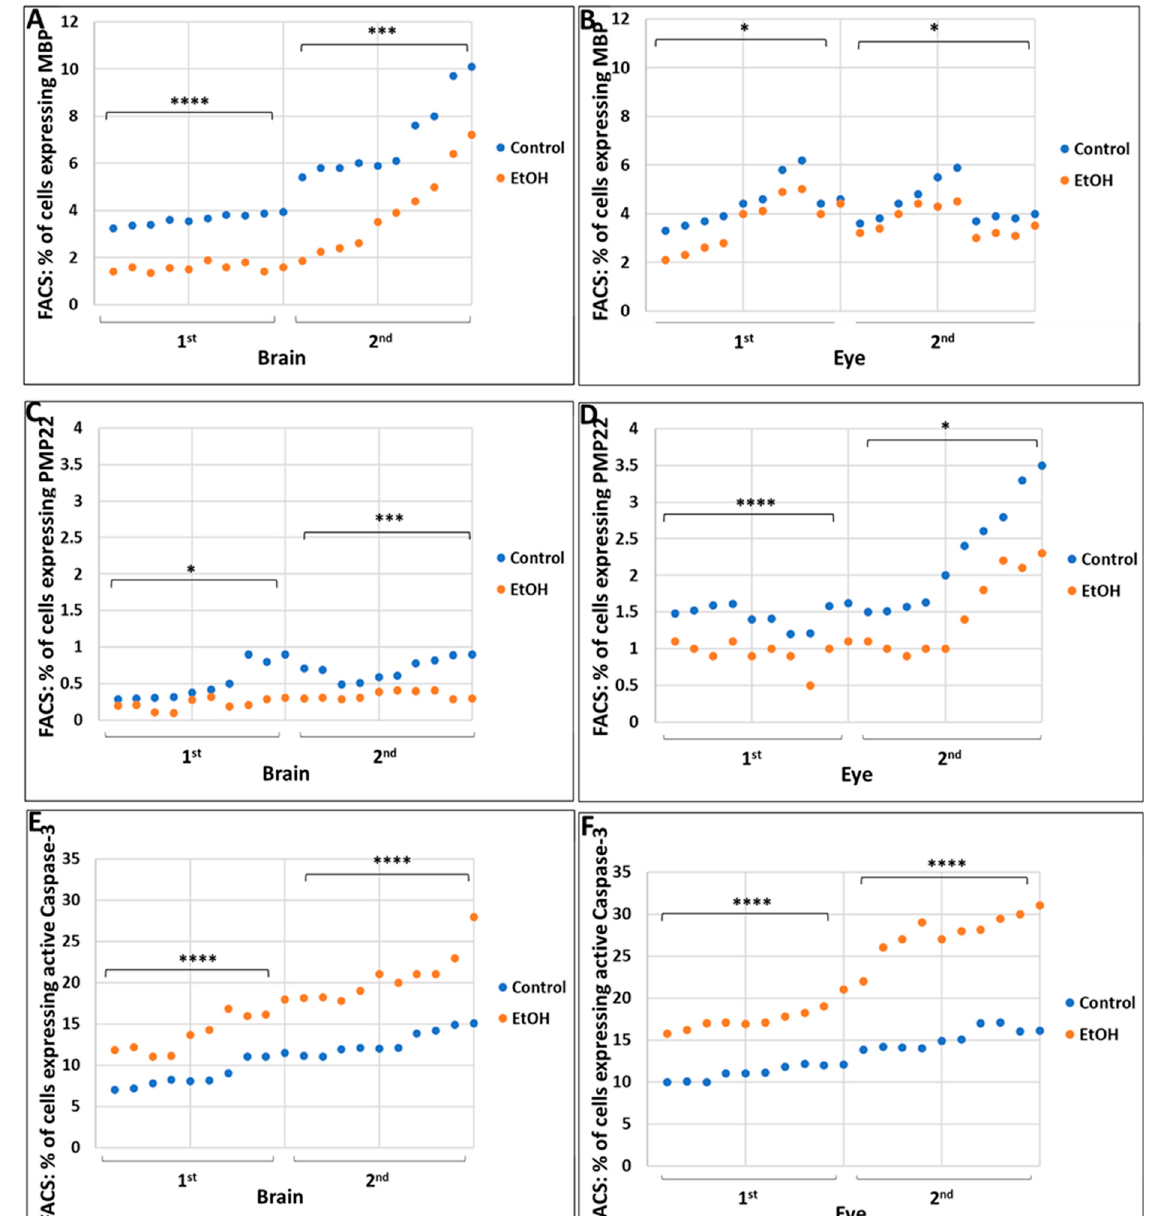
Figure 1. Prenatal alcohol exposure inhibits expression of markers for mature myelin, MBP and PMP22, and activates caspase-3 in human fetal brain and eye. The percentage of cells expressing molecular markers were determined by FACS in brains and eyes of fetuses exposed to EtOH, and compared with non-exposed controls. ( A ) EtOH-dependent reduction in the proportion of cells expressing the late stage OL marker, MBP, in brain and eye ( B ). ( C ) EtOH-dependent reduction of the expression of Schwann cell marker PMP22 in brain and eye ( D ). ( E ) EtOH-induced increases in the proportion of cells expressing the pro-apoptotic marker, activated caspase-3 in brain and eye ( F ). Twenty EtOH-exposed fetuses were compared with 20 individually matched unexposed controls, 10 matched pairs from the 1st trimester and 10 from the 2nd trimester. Each dot represents the average of triplicate measurements for that fetus. Significance levels are for the comparison between all EtOH-exposed and all unexposed controls within the indicated trimester (1st or 2nd), based on ANOVA. * p < 0.05; *** p < 0.001; **** p < 0.0001.